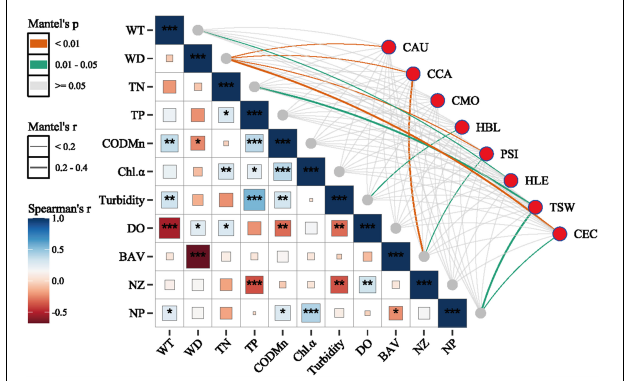
FIGURE 5 | Results from Spearman correlation analyses and Mantel’s tests assessing associations among different environment variables and among environmental variables and the dominant species of fish sampled from the Mangshe River (MR) and different purification zones of Lake Yanlong (PZ, the pretreatment zone; EZ, the emergent macrophyte zone; SZ, the submerged macrophyte zone; DZ, the deep purification zone). WT, water